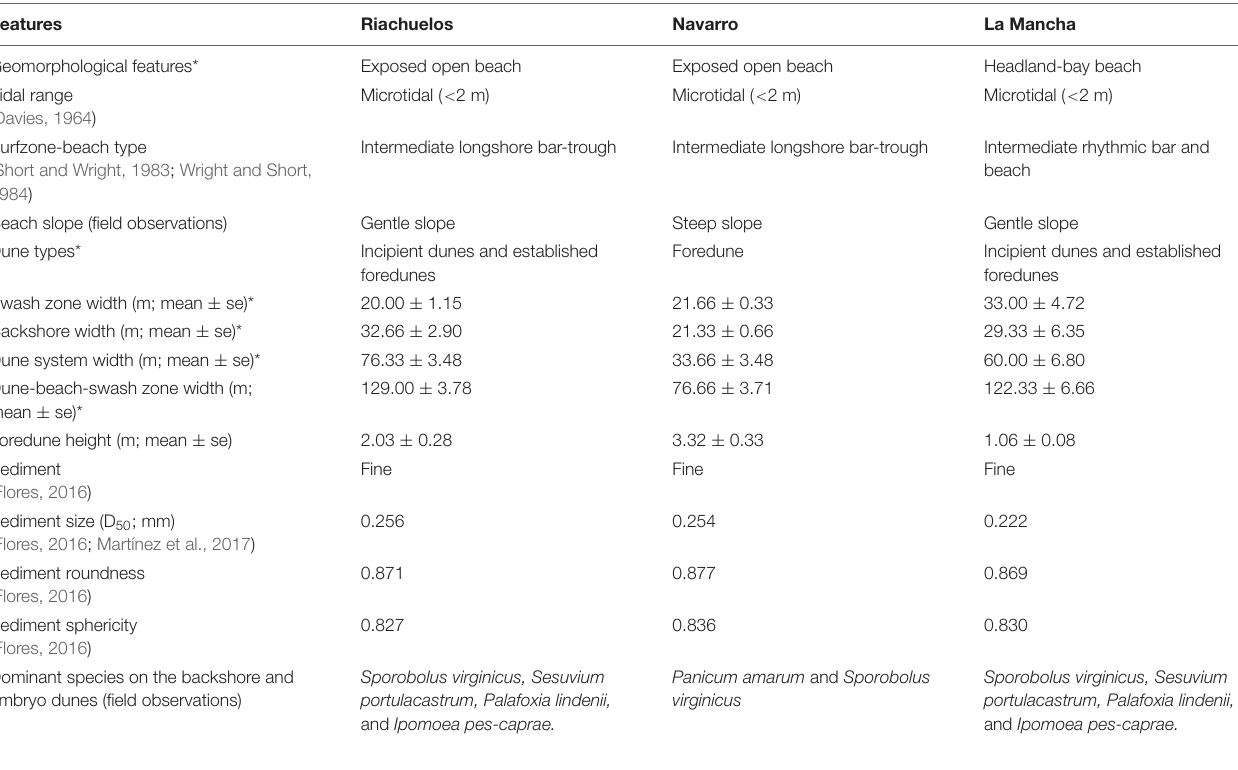
TABLE 1 | Main geomorphological attributes of the beaches studied (* geomorphological features estimated from field surveys performed before the storm).